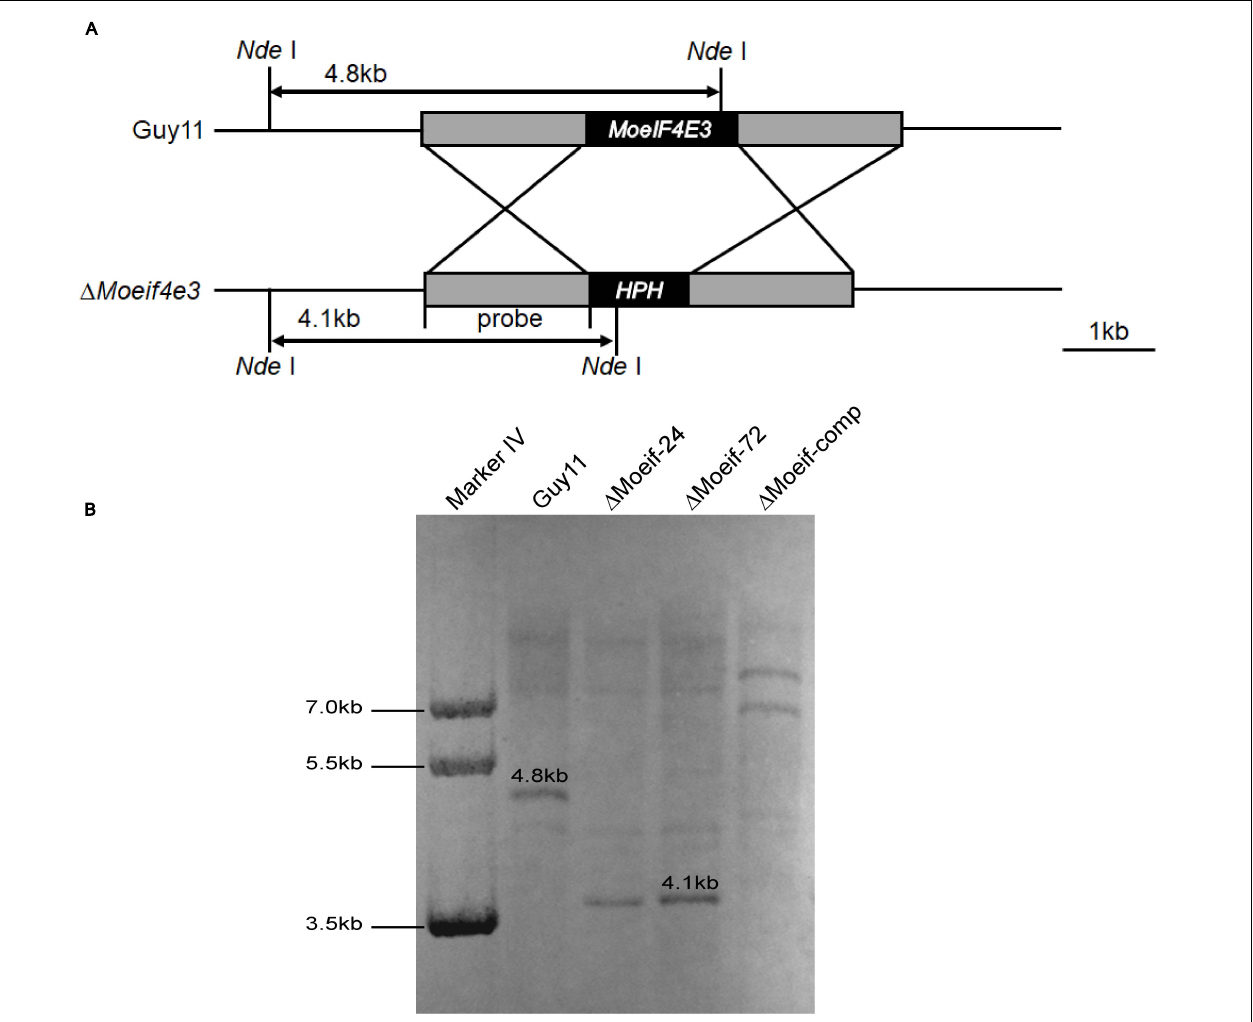
FIGURE 2 | Targeted gene deletion of MoeIF4E3 in M. oryzae . (A) Schematic presentation of targeted disruption of MoeIF4E3 using homologs recombination approach. (B) Southern blot results showing successful replacement of MoeIF4E3 by a single insertion of Hygromycin phosphotransferase (hph) ORF at MoeIF4E3